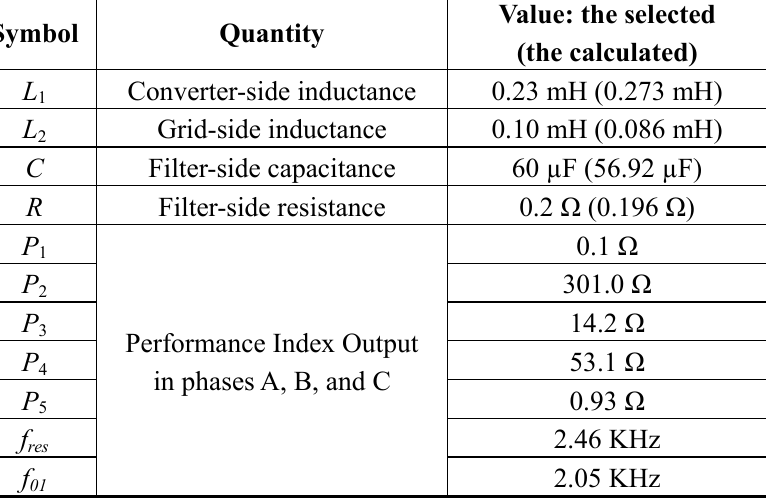
Table 3. Parameters selected and its performance index in phases A, B, and